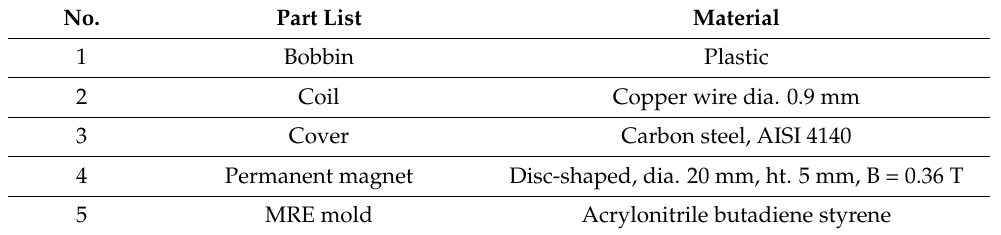
Table 3. List of parts and materials for the fabrication of electromagnetic coil.